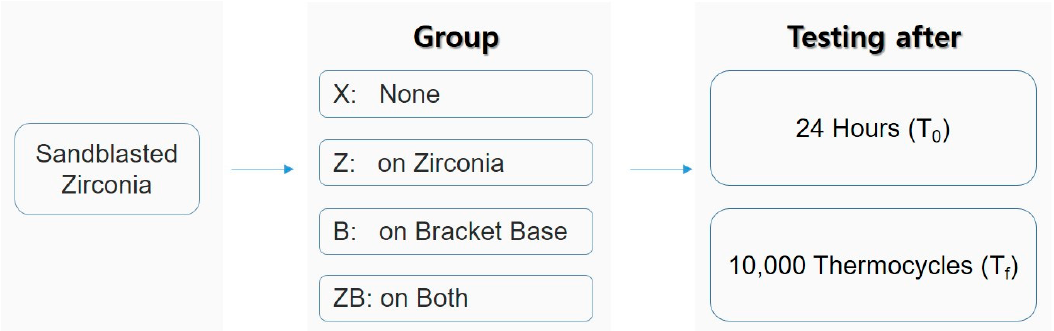
Figure 1. Flowchart of the experiment.